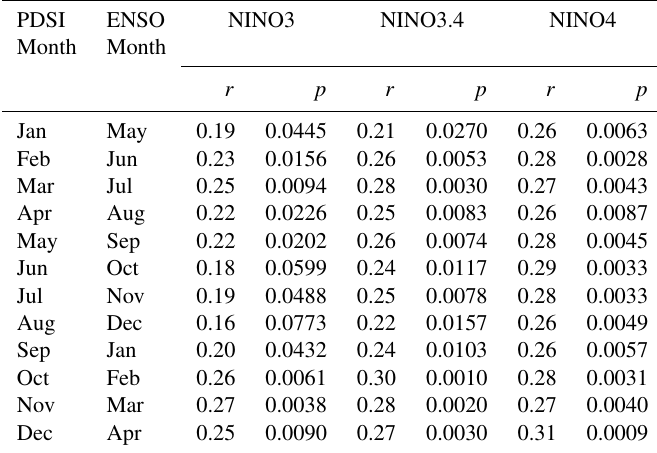
Table 2. Correlation coefficients ( r ) and p values between the monthly ENSO index and the reconstructed PDSI with a lag of 8 months calculated by the KNMI Climate